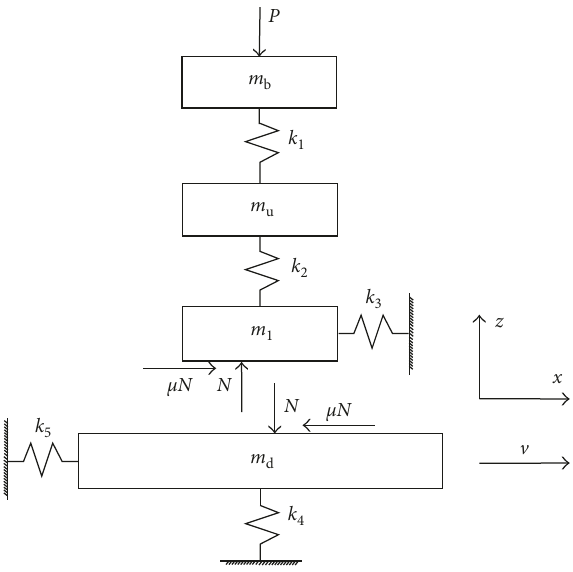
Figure 1: Six-DOF kinematics model of brake disc-brake